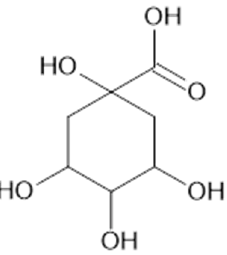
Figure 20. Chemical structure of compound 94 (MW = 192).